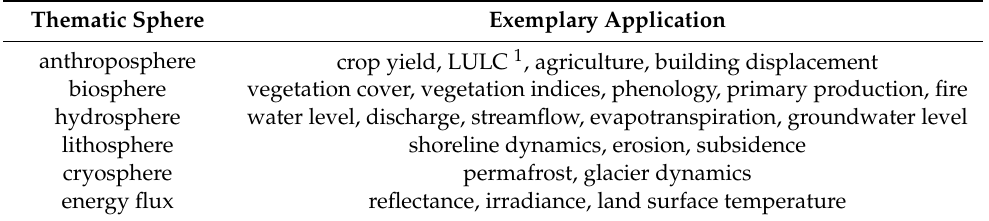
Figure 2. Research topics of EO-based forecasting studies: ( a ) Number of studies published per year according to application sphere; ( b ) Share of reviewed studies according to each application sphere. Table 2. Examples of reviewed EO-based forecast applications according to thematic